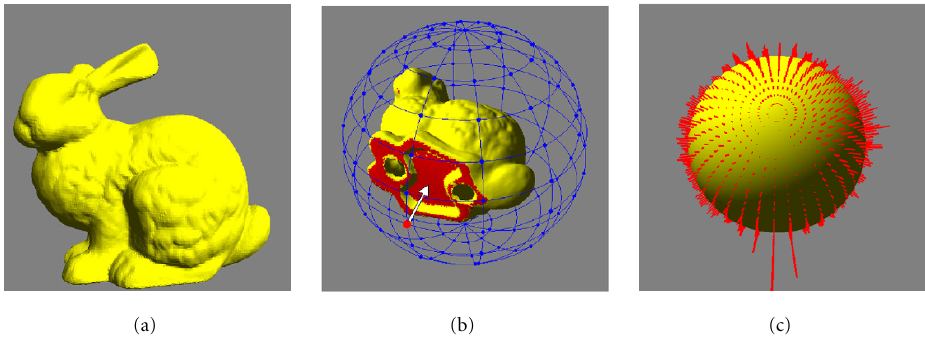
Figure 5: Viewpoint sampling method. (a) Bunny model. (b) View samples and a specific mapping. (c) Extended Gaussian image (EGI) of the Bunny